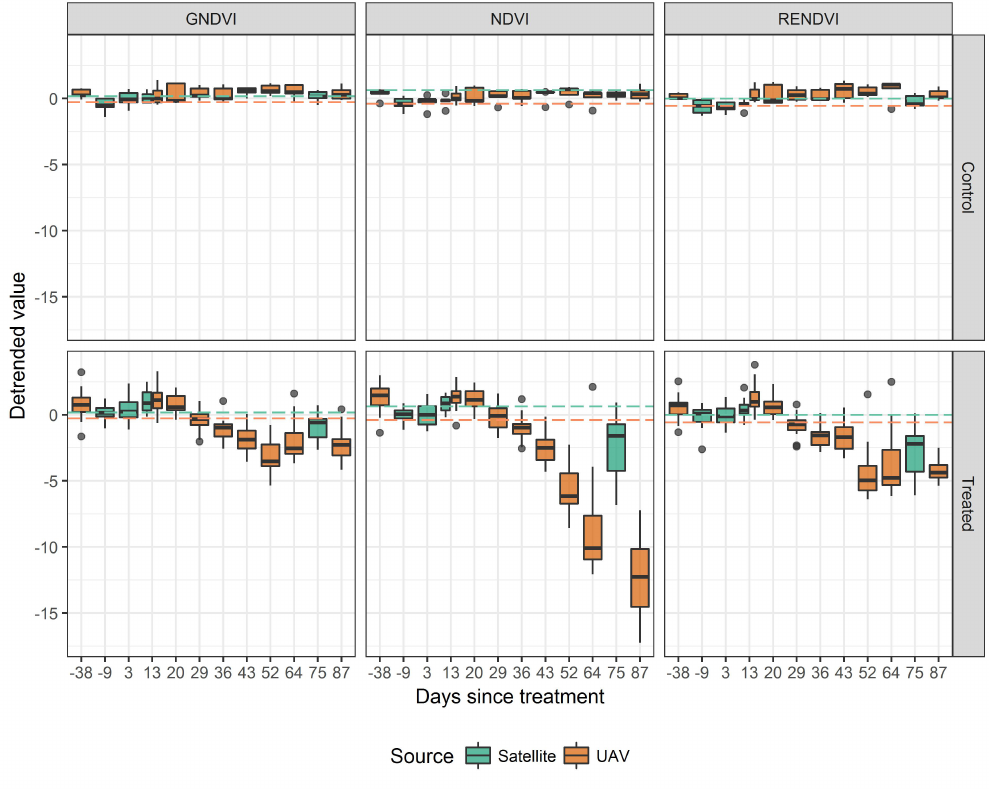
Figure 2. Box and whisker plots showing the distribution of three de-trended spectral indices derived from the two different sensors for control (n = 5) and treated (n = 25) plots over the course of the experiment.The dashed lines show the lower bound of the ’no-change’ zone calculated from both treated and control plots during the first time step. Change is deemed to have occurred once the upper hinge of the box plot is below the ’no-change’